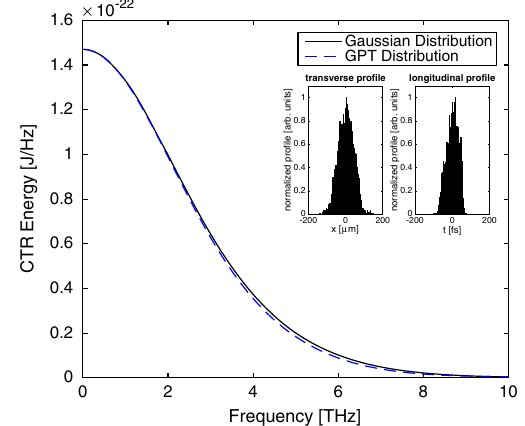
FIG. 7. The energy spectrum calculated from Gaussian dis- tribution and the GPT simulation distribution. In the inset, we show the transverse and longitudinal profiles of the bunch.